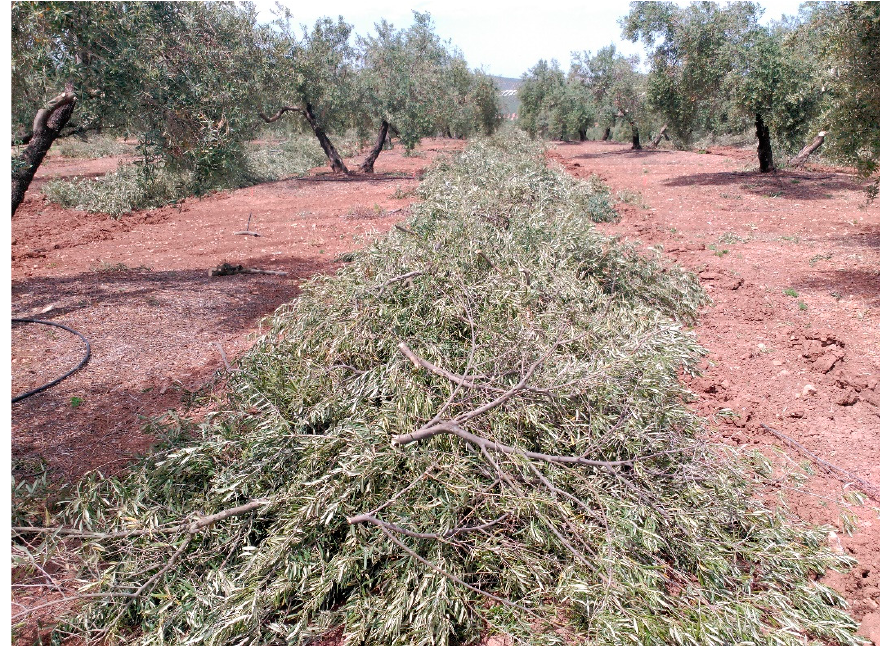
Figure 2. Windrow replication of 20 m length before shredding. Branches were placed transversally to the tractor’s forward direction, leaving trunks in the center of the windrow.